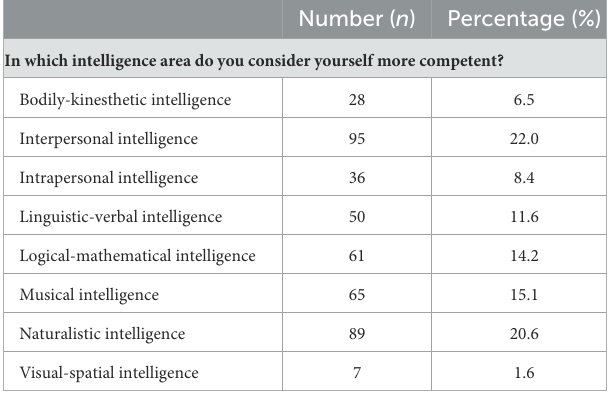
TABLE 2 Self-perceived intelligence types of university students.